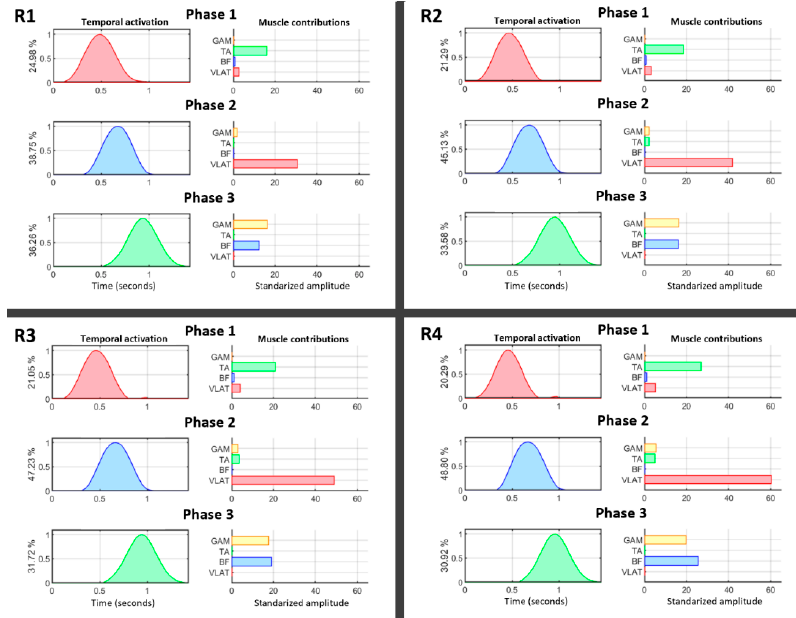
Figure 4. Cycling phase decomposition for all four resistance levels ( R1 – R4 ): phase 1, traction phase; phase 2, initiation of the power phase; phase 3, end of the power phase. The normalized temporal activation ( left ) and the contributions of muscles ( right ) are shown for each phase. The percentages shown along the y -axes of the temporal activation graphs represent the relative contribution of each phase to the total motion